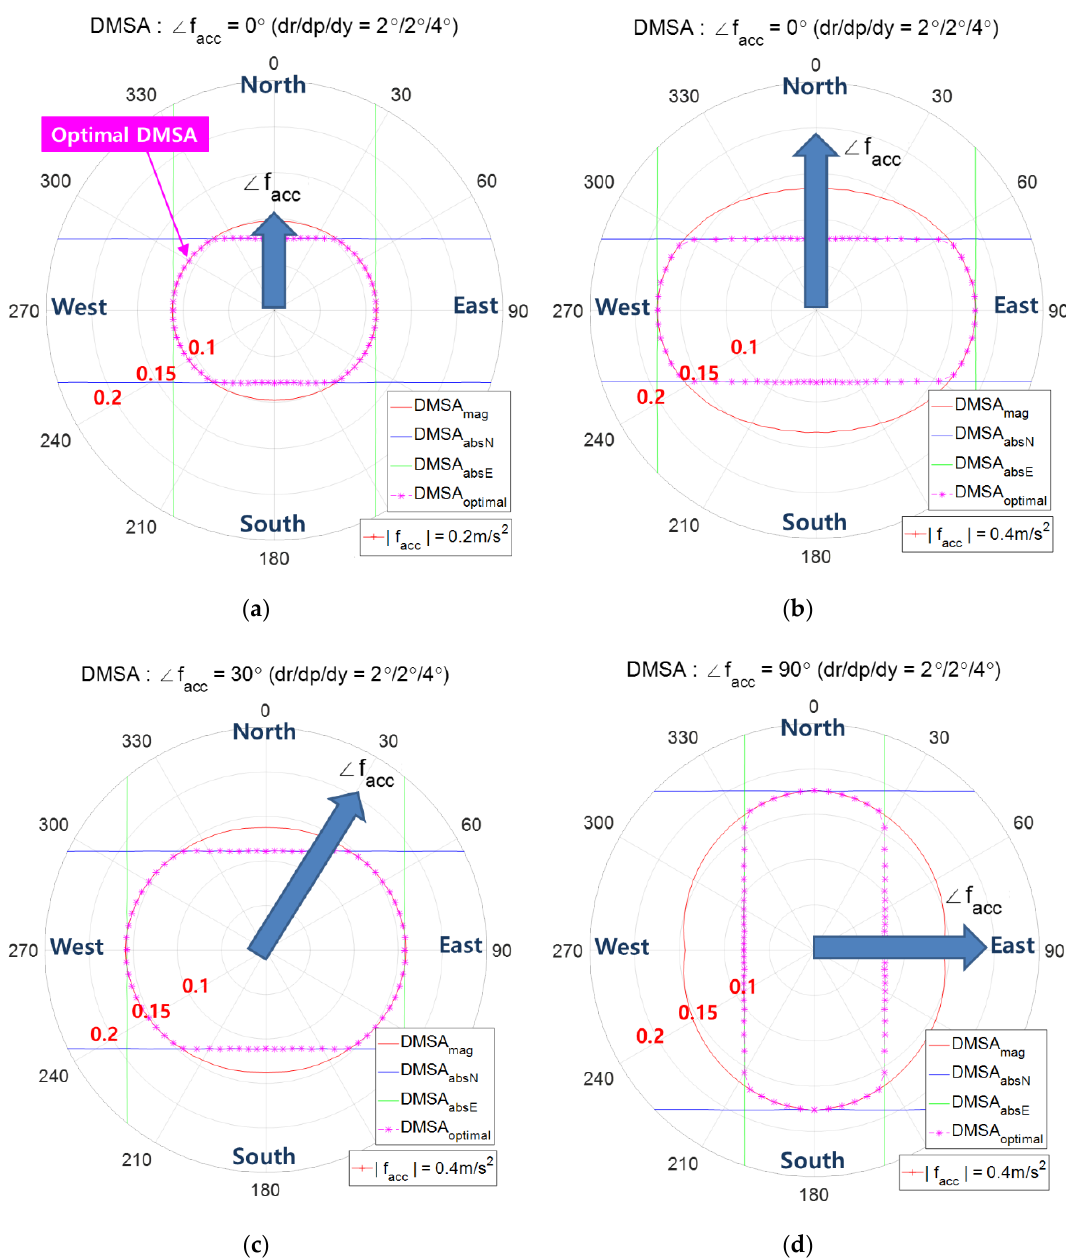
Figure 14. Optimal combined contour (pink color) of DMSA using both 𝑧 𝑚𝑎𝑔 and 𝑧 𝑎𝑏𝑠𝑁 , the angle denotes the direction of 𝒇 𝒔 , i.e., ∠ 𝒇 𝒔 ; ( a ) ∠𝐟 𝐚𝐜𝐜 = 0 °, | 𝐟 𝐚𝐜𝐜 | = 0.2 m/s 2 , ( b ) ∠𝐟 𝐚𝐜𝐜 = 0° , | 𝐟 𝐚𝐜𝐜 | = 0.4 m/s 2 , ( c ) ∠𝐟 𝐚𝐜𝐜 = 30° , | 𝐟 𝐚𝐜𝐜 | = 0.4 m/s 2 , and ( d ) ∠𝐟 𝐚𝐜𝐜 = 90° , | 𝐟 𝐚𝐜𝐜 | = 0.4 m/s 2 .